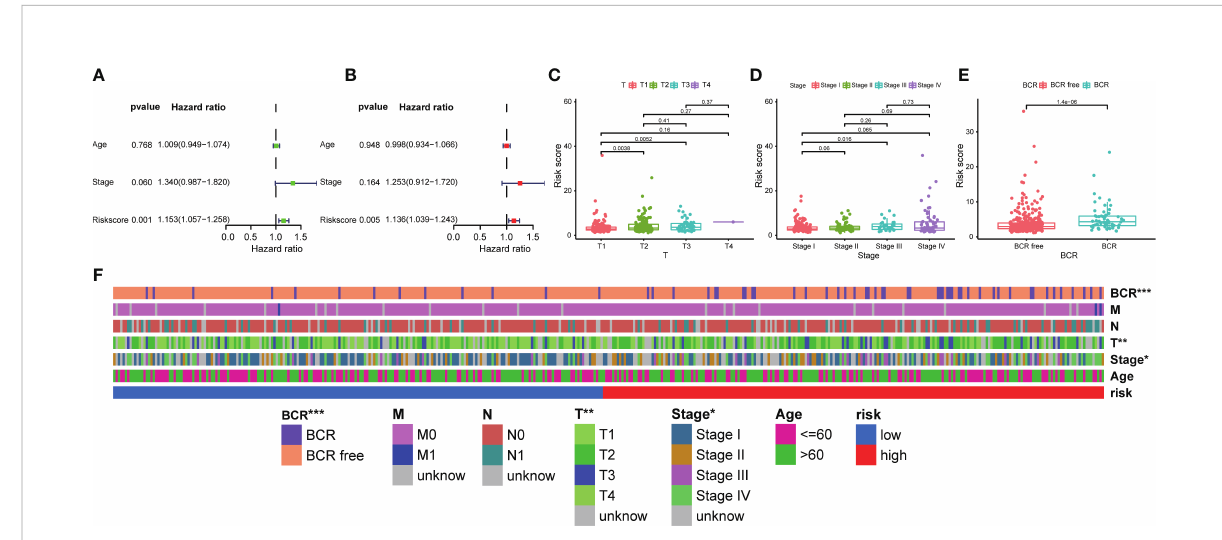
FIGURE 5 Correlation between prognostic signature and clinical features. (A) Univariate and (B) multivariate regression analyses of the signature in the training TCGA-PRAD cohort. The scatter diagrams indicated higher risk score meant advanced (C) T stage, (D) stage, and more (E) BCR events in the entire TCGA-PRAD cohort. (F) The band diagram of clinical features between the high- and low-risk groups in the entire TCGA-PRAD cohort. * p<0.05, ** p<0.01, and ***